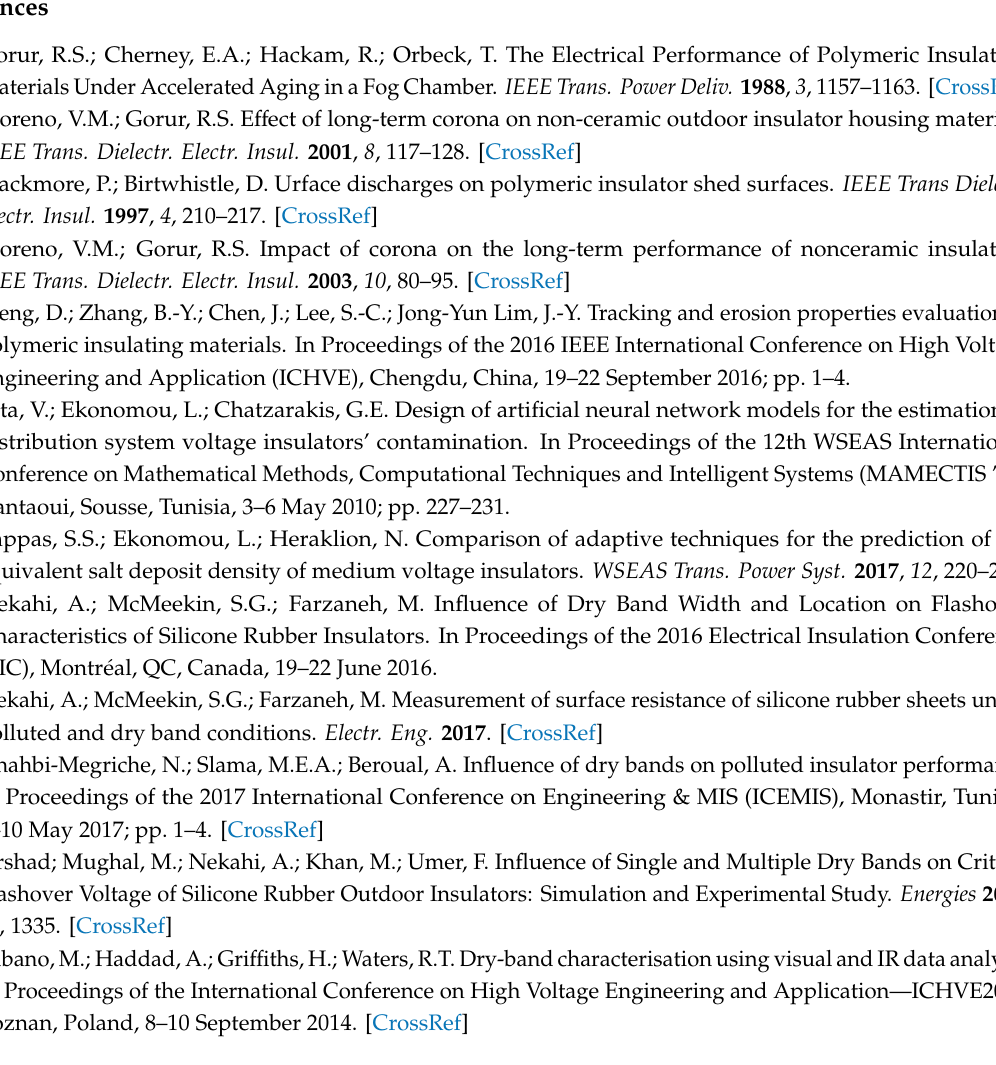
Figure A4. 3D representation of dry-band development on each trunk. Ramp-test: Design CONV, ESDD = 0.42 mg/cm 2 , and a fog rate of 3 L/hr.